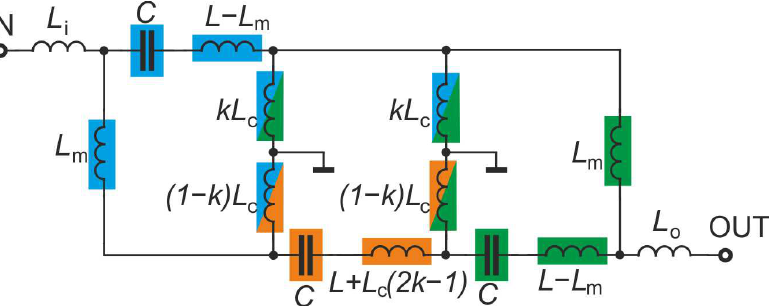
Figure 2. Lumped element triple-tuned multiple-coupled bandpass